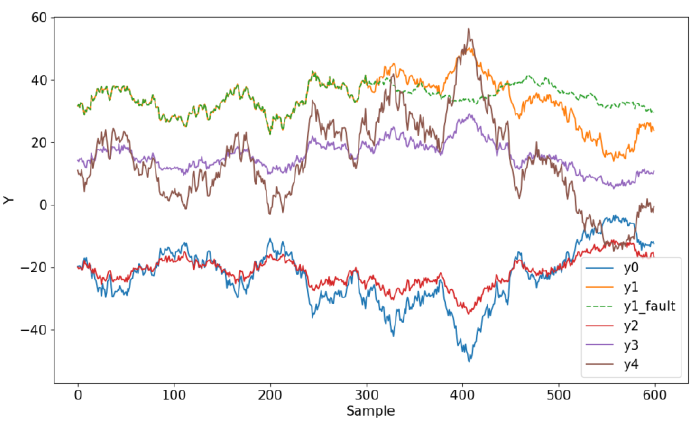
Figure 7. Test and fault data sample.